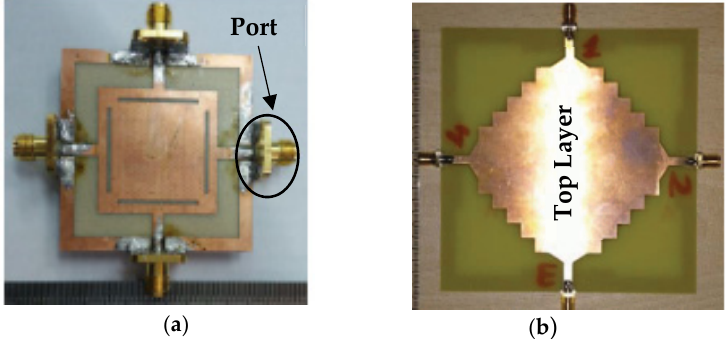
Figure 18. ( a ) Common radiator with square ring ground [82], ( b ) Quad-port MIMO antenna [83].